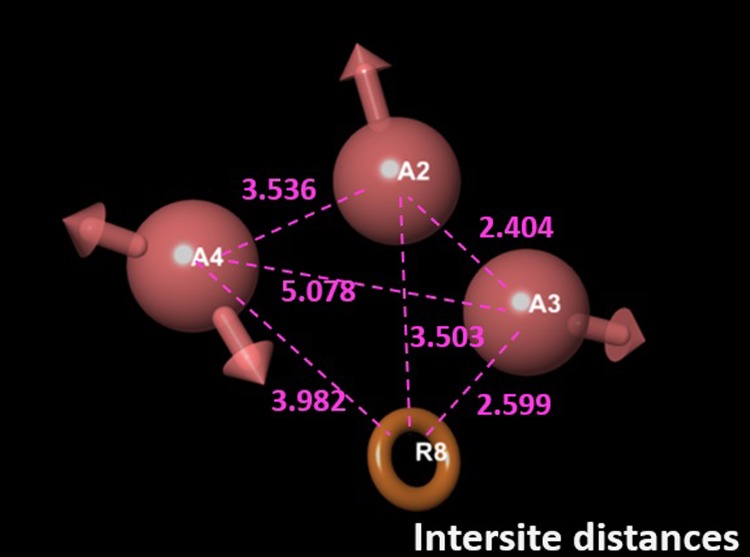
The inter-site distances between model AAAR.2.Distances are in the unit of Å.